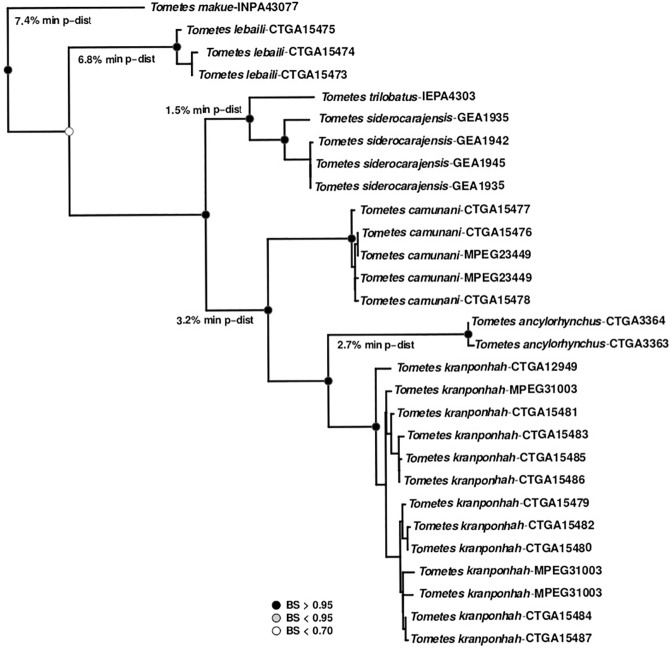
Neighbor-joining (NJ) tree of 28 mitochondrial cytochrome c oxidase subunit I gene sequences from seven Tometes species using uncorrected p-distance, showing the correct discrimination by distance genetic approach of the all species.Bootstrap values based on 1000 replicates are indicated at the branches.